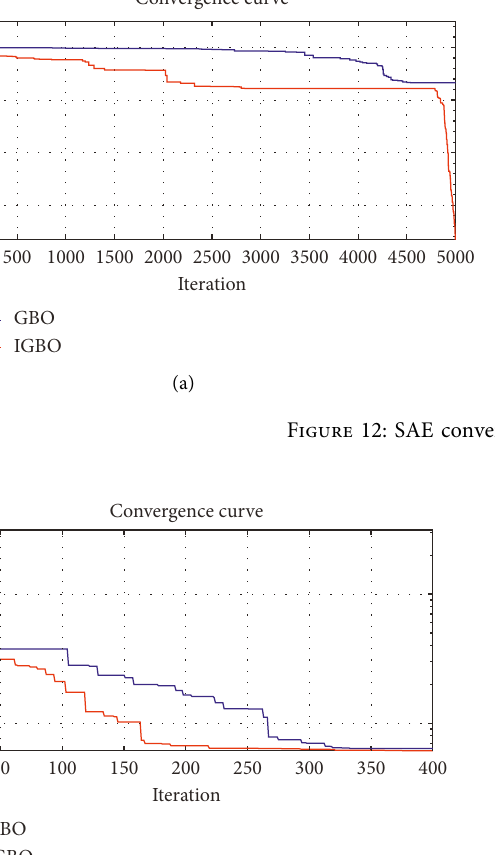
Figure 13: SAE convergence for model 8.